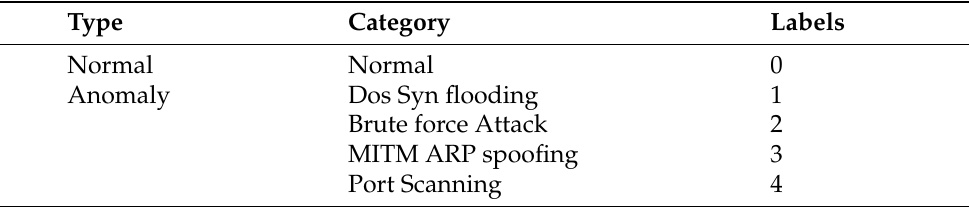
Table 3. Configuration parameters of the